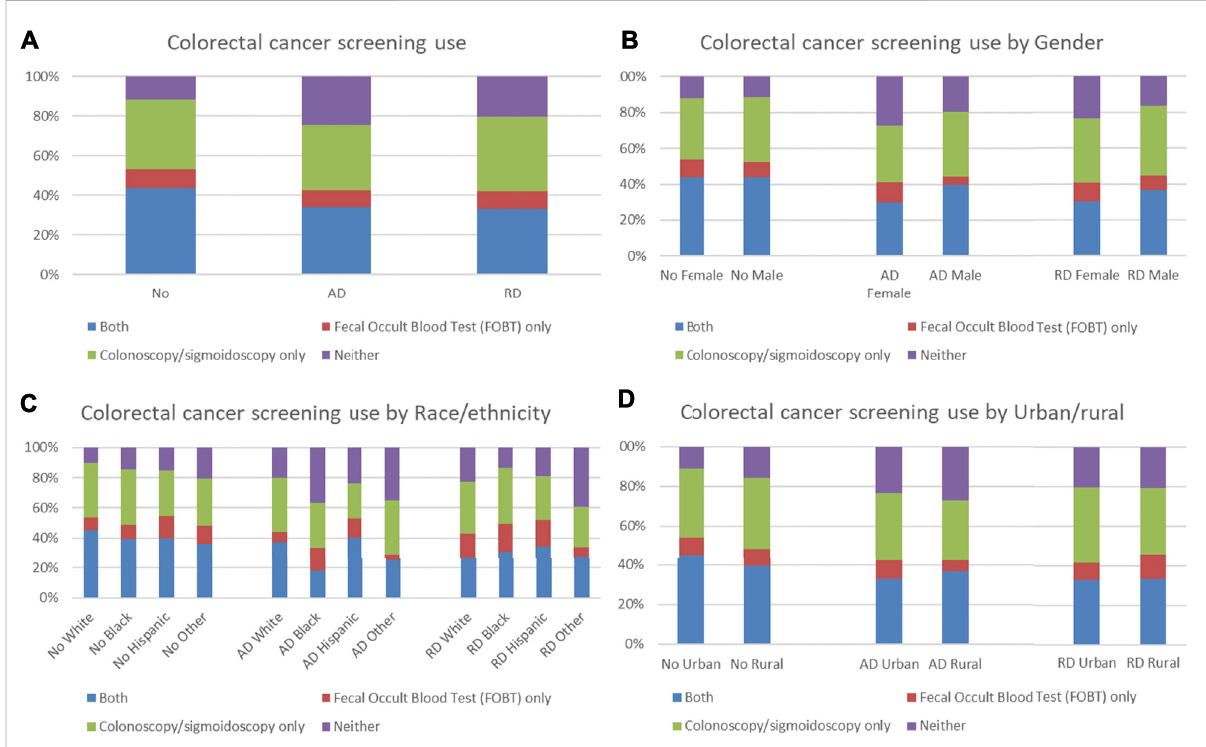
FIGURE 4 Distribution of types of colorectal cancer screening use by ADRD status (A) . Overall distribution; (B) . Distribution by gender; (C) . Distribution by race/ethnicity; (D) . Distribution by